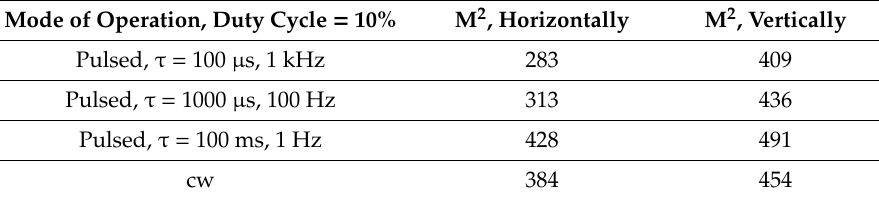
Table 2. Beam quality factor M 2 for the pump module for various pulse widths and cw in horizontal and vertical direction, obtained from fitting to the data in Figure 3.